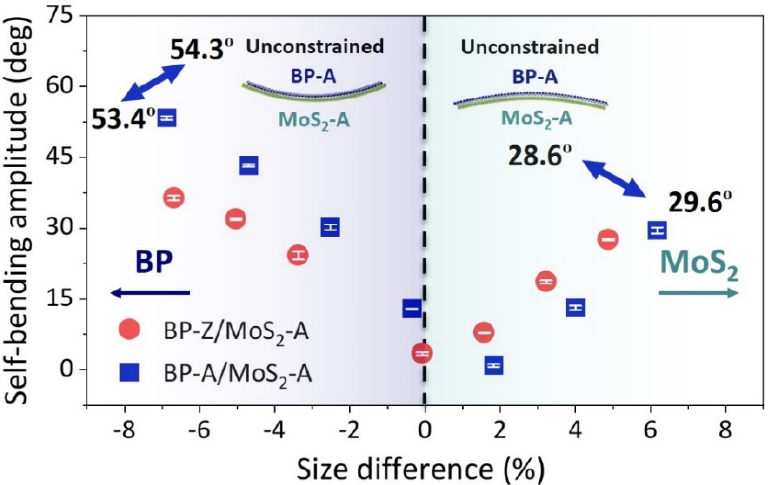
Figure 4. The self-bending amplitudes of BP-A/MoS 2 -A and BP-Z/MoS 2 -A with the size difference and stacking order. The errors are the average of three fitting results within different ranges around the configuration with minimum potential energy. The blue and green arrows represent the directions of self-bending towards BP and MoS 2 , respectively. The insets show the self-bending configurations of BP-A/MoS 2 -A with SD = − 6.87% and SD = 6.17% without the spring constraint.